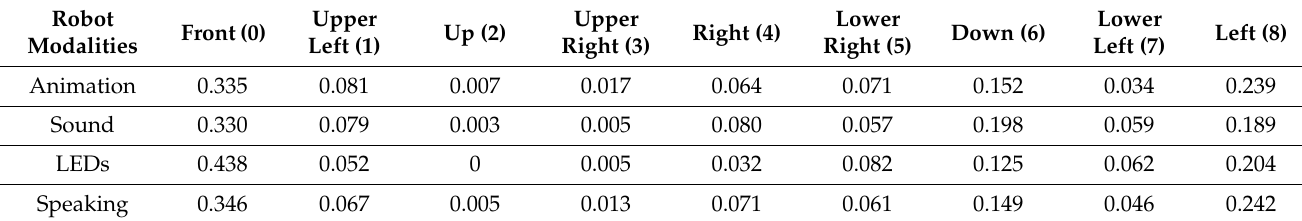
Table 3. Probability masses over the states for four different robot